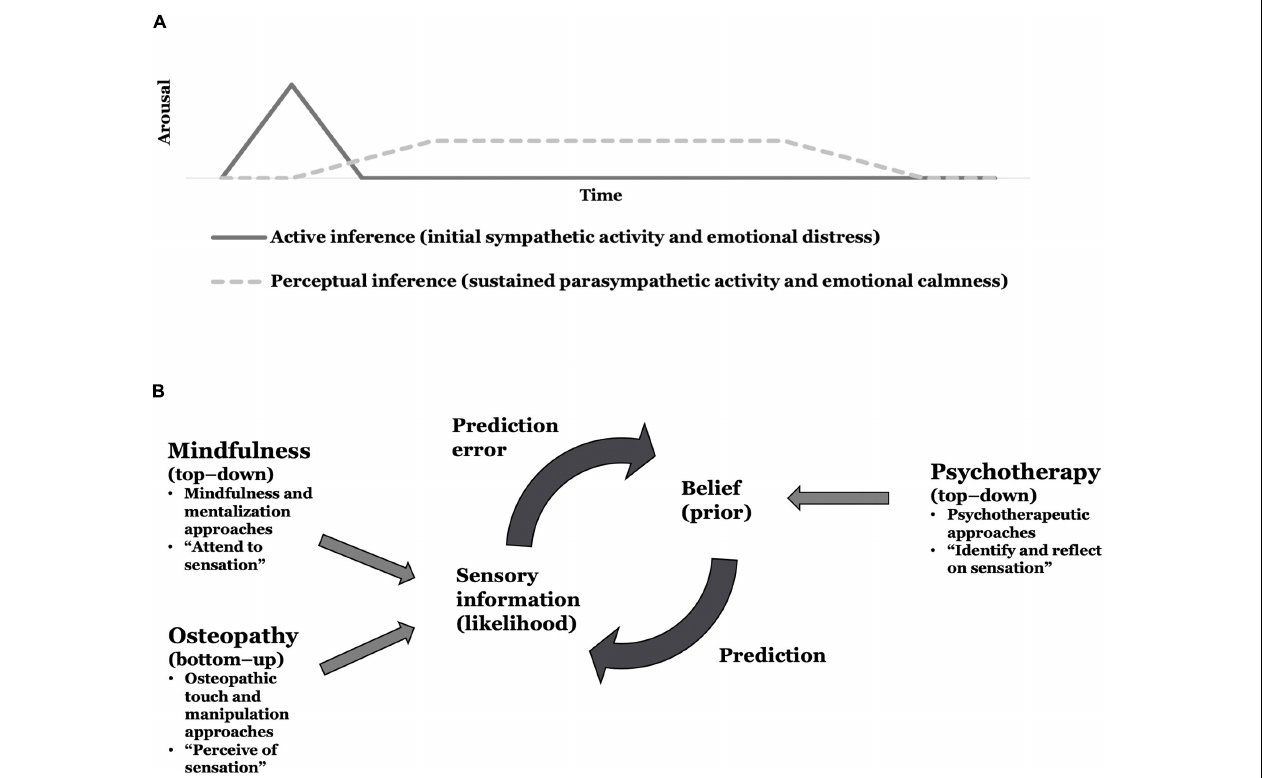
FIGURE 3 | Implications for future research testing the theoretical framework. (A) An active and perceptual inference perspective to reason autonomic and emotional responses in osteopathic practice. (B) A proposition for a multidisciplinary interoceptive exposure therapy to physical and comorbid mental symptoms or conditions.